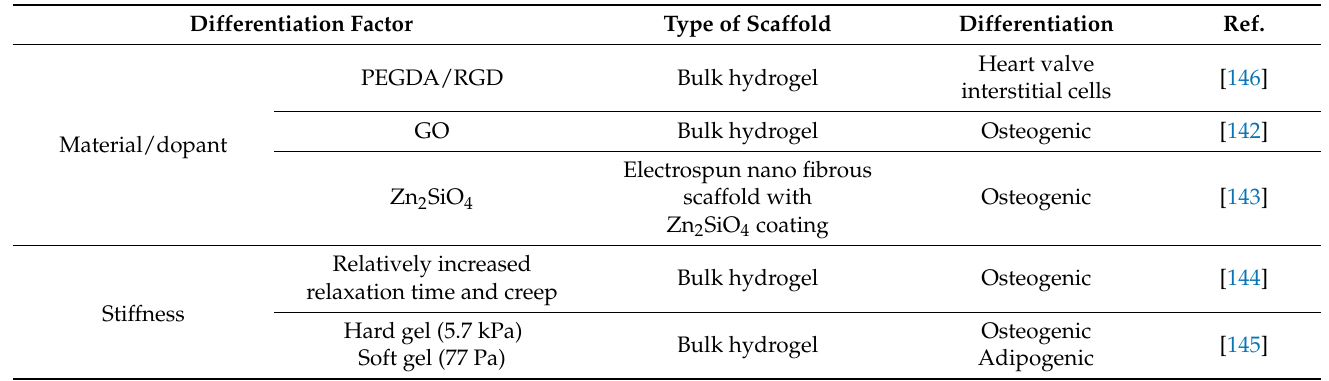
Table 3. Influence of polyethylene glycol and its derivative on cell differentiation. Type of